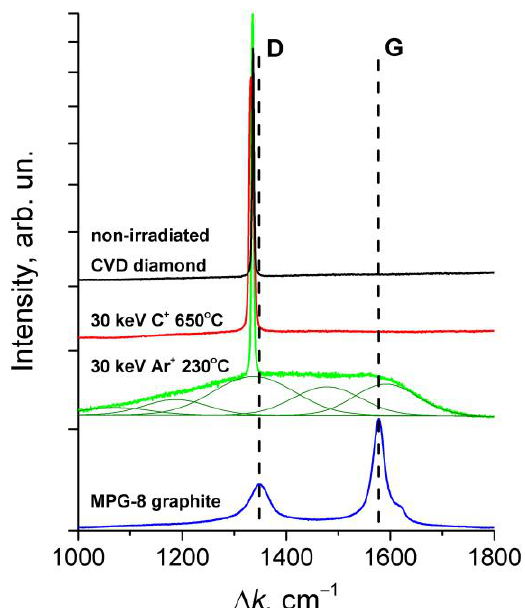
Figure 4. Raman spectra for chemical vapor deposition (CVD) diamond before and after irradiation by 30 keV Ar + and C + ions. Spectrum for polycrystalline graphite MPG-8 was measured for comparison. The Gaussian analyses of the spectrum are shown by thin lines for diamond irradiated with Ar + ions.